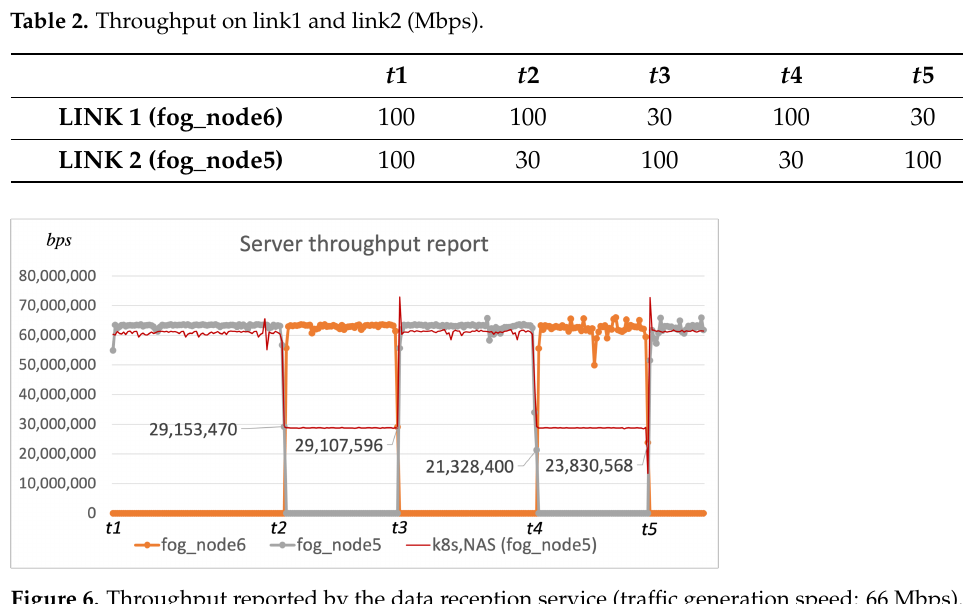
Figure 6. Throughput reported by the data reception service (traffic generation speed: 66